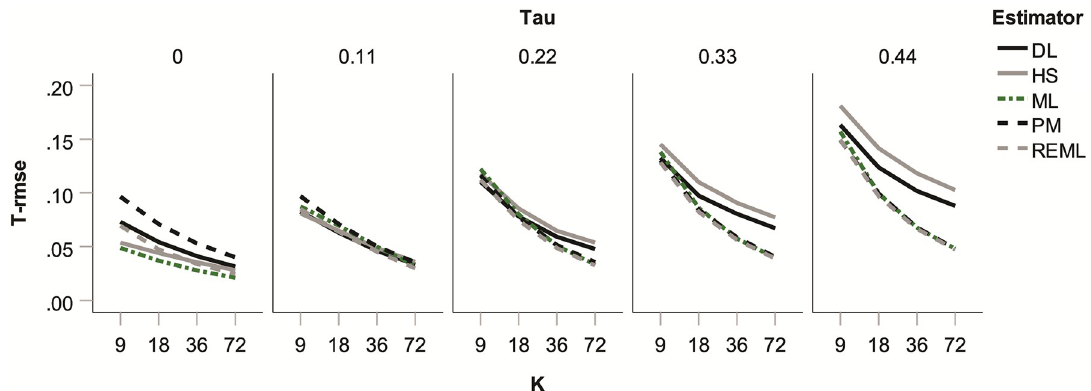
Fig 3. Root mean square error for heterogeneity estimates ( T RMSE ) in the absence of publication bias and p -hacking for five heterogeneity estimators as a function of true heterogeneity ( τ ) and number of studies in the meta-analysis ( k ).